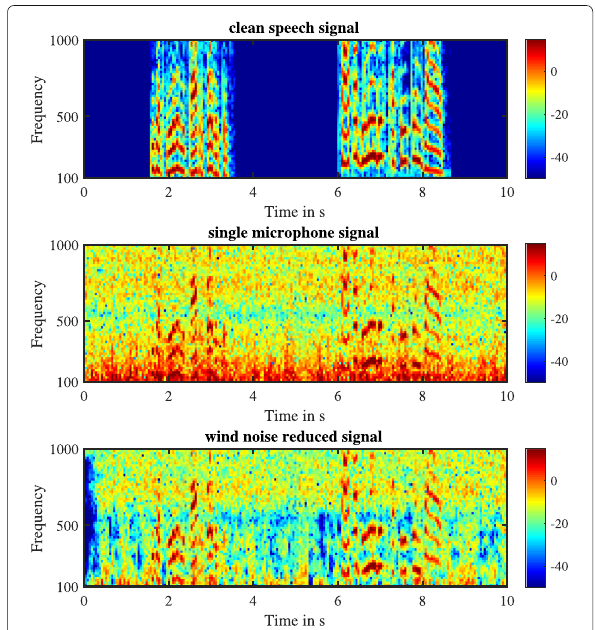
Fig. 3 Spectrogram for a single microphone Y 1 (middle) and the output signal Z from (46) (bottom)